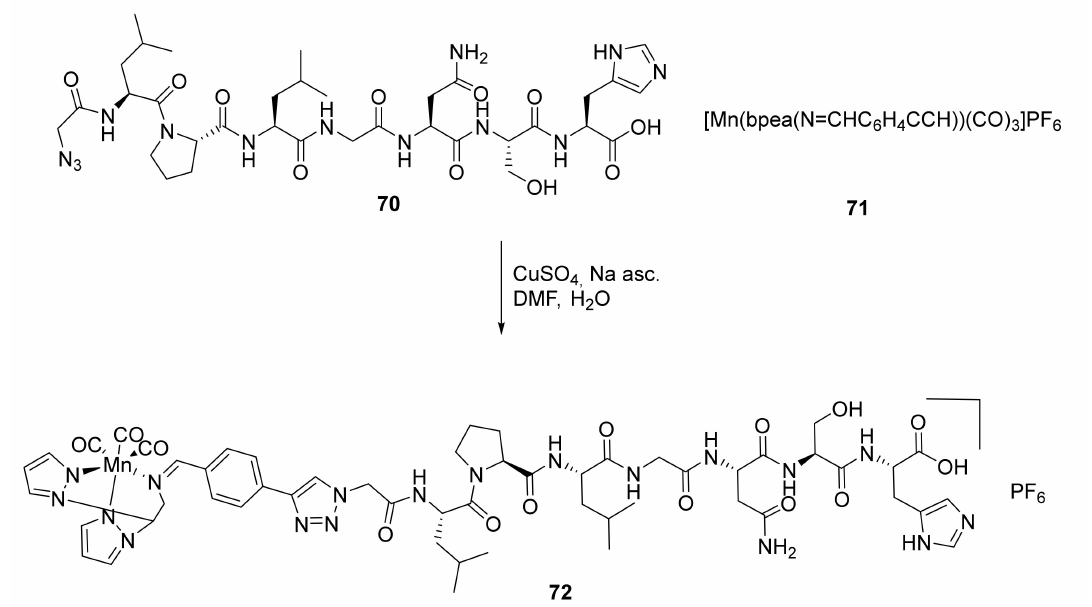
Scheme 9. Synthesis of conjugated peptide 72 by